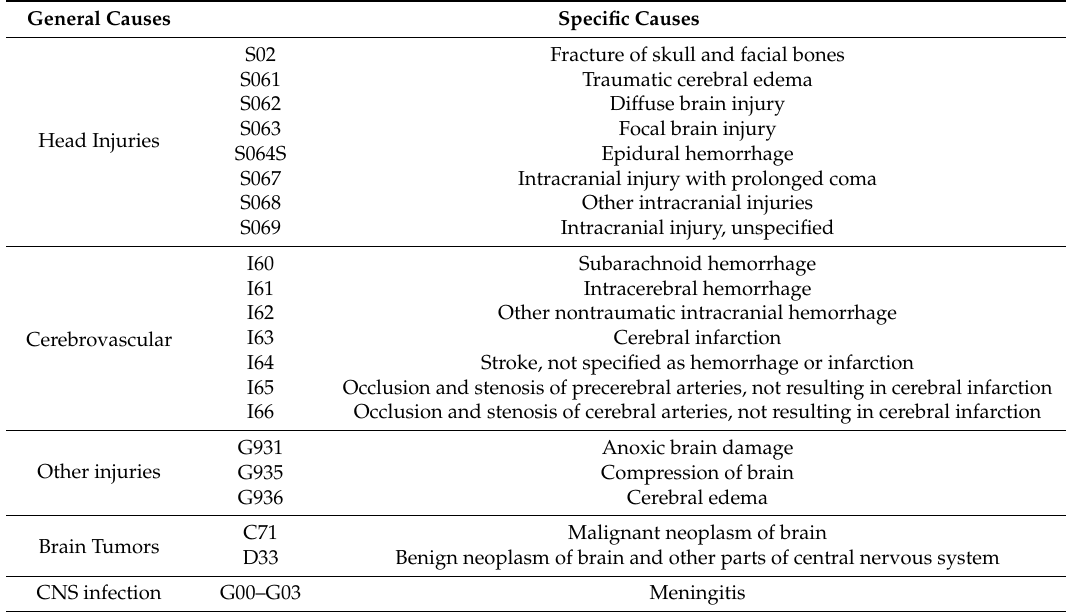
Table 1. ICE-10 Codes compatible with possible brain death